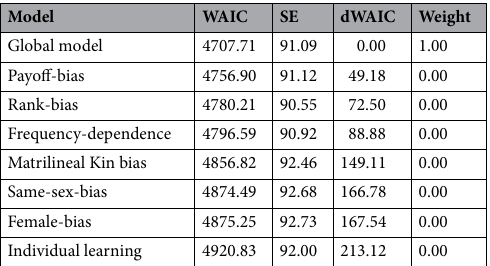
Table 1. Widely applicable information criteria estimates for all evaluated models with a 20 min window of social information. Standard errors, difference in WAIC and model weight are